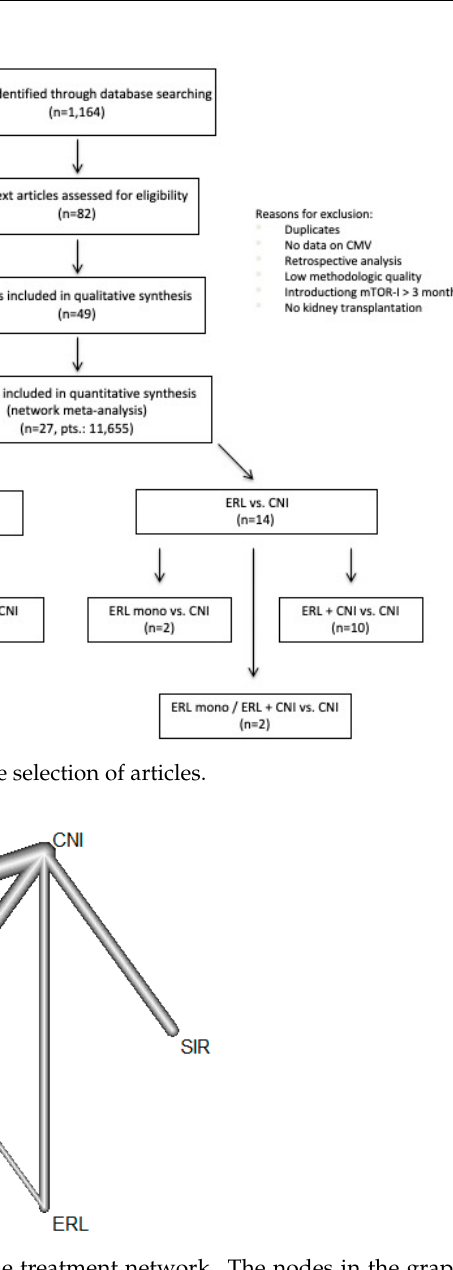
Figure 2. Geometry of the treatment network. The nodes in the graph layout correspond to the treat- ments, and the edges display the observed treatment comparisons. The thickness of the edges is proportional to the number of participants in trials, directly comparing the four connected treat- ments.